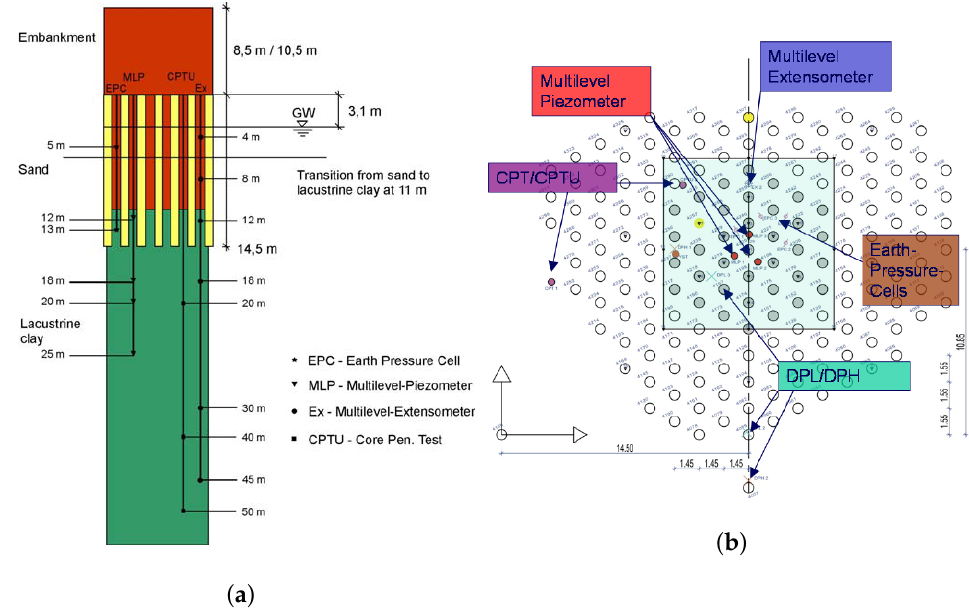
driven to a level slightly above the desired depth. Figure 6. Details of Klagenfurt site. ( a ) Cross-section with soil layers and measuring devices; ( b ) plan The last 0.5m the cell is pushed into the soil.